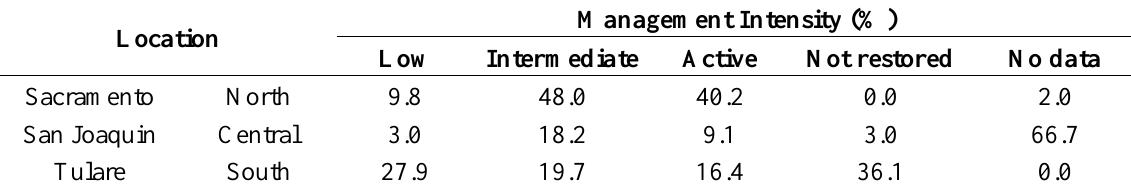
Table 1. Distribution of Wetlands Reserve Program (WRP) in California’s Central Valley categorized by management intensity within each sub-basin. Management intensity information was derived from interviews with 77 land owners, managers, WRP easement contract records and Natural Resources Conservation Service (NRCS) staff [13]; management categories are described in the Experimental Section.